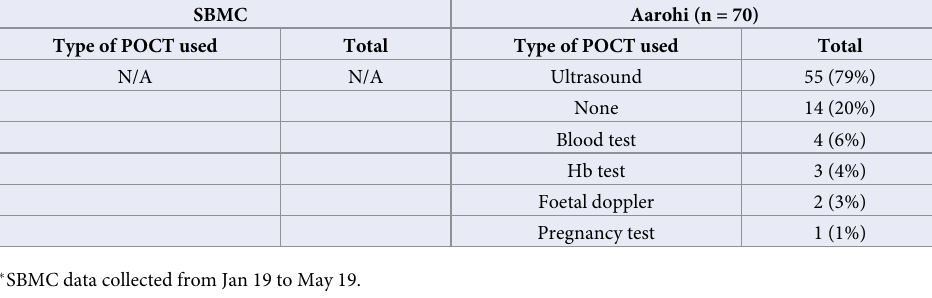
Table 3. Data from SBMC � and Aarohi �� on types of POCT used during consultation.